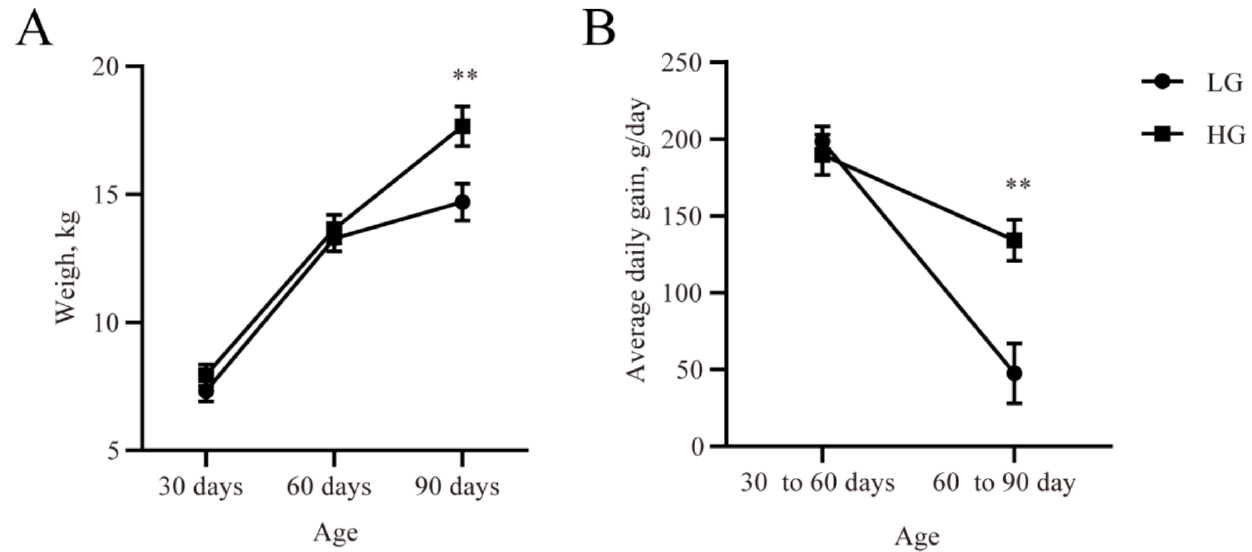
Figure 1. The live weight ( A ) and average daily gain at different lamb ages ( B ). Data are expressed as mean ± SE. ** p < 0.05. LG: the weaned lambs with lower average daily gain. HG: the weaned lambs with higher average daily gain.